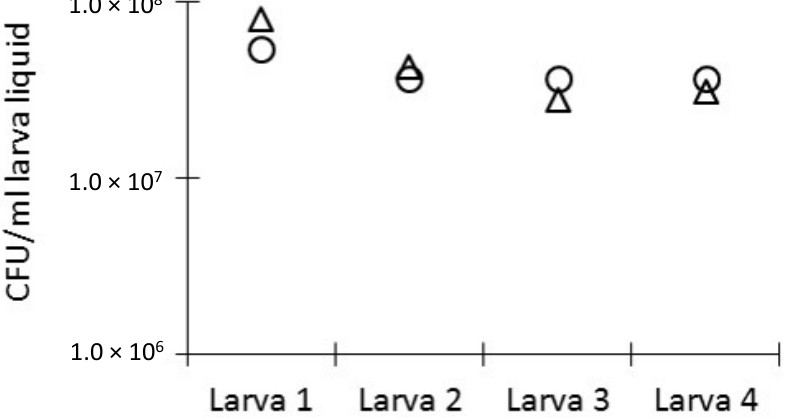
Figure 3. In vivo bacterial load in G. mellonella larvae. Larvae were infected with a known concentration of E. coli equal to 1.3 × 10 7 CFU/larva, as confirmed by plate counting. The theoretical in vivo bacterial concentration was calculated based on larva liquid volume calculated from the curve. Immediately after infection, larvae were sacrificed and bacterial load was determined in their haemolymph by viable counts. The theoretically calculated ( ○ ) in vivo concentration was very similar to the measured ( ∆ ) concentration.